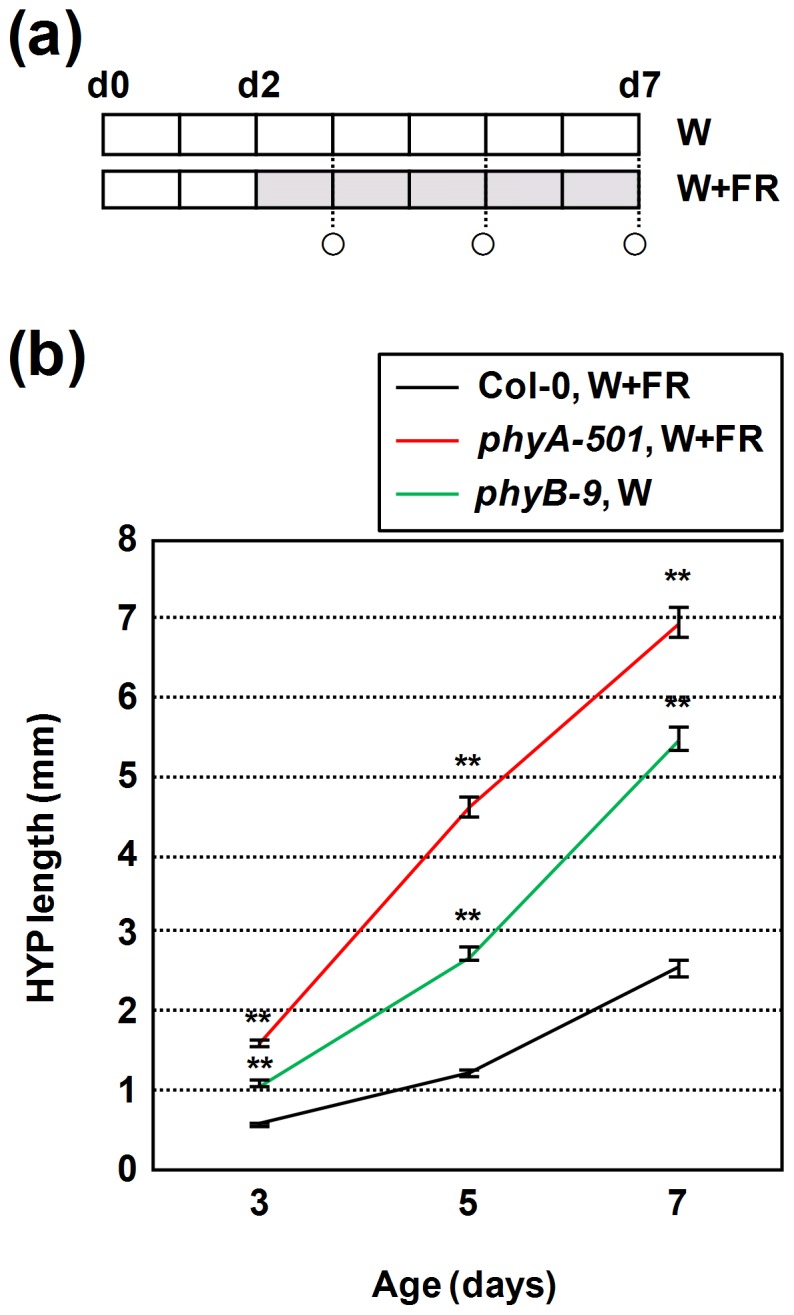
Effect of phyA and phyB mutations on the temporal evolution of the hypocotyl length.(a) Seeds were germinated and grown for 2 days under W (PAR was of 20–25 µmol·m−2·s−1) and then either kept under W (phyB seedlings) or transferred to W+FR (R:FR = 0.038) for 5 more days (Col-0 and phyA seedlings). Circles indicate the days on which hypocotyls were measured. (b) Hypocotyl length of seedlings grown as indicated in a. Values are means ± SE of at least 25 hypocotyls for each light treatment. Asterisks indicate significant differences (*P<0.05, **P<0.01) relative to the wild type seedlings grown under the corresponding light conditions.